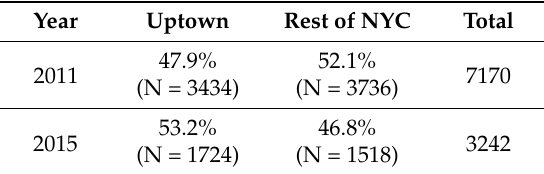
Table 3. Distribution of residual fuel burning buildings (#4 and #6) from